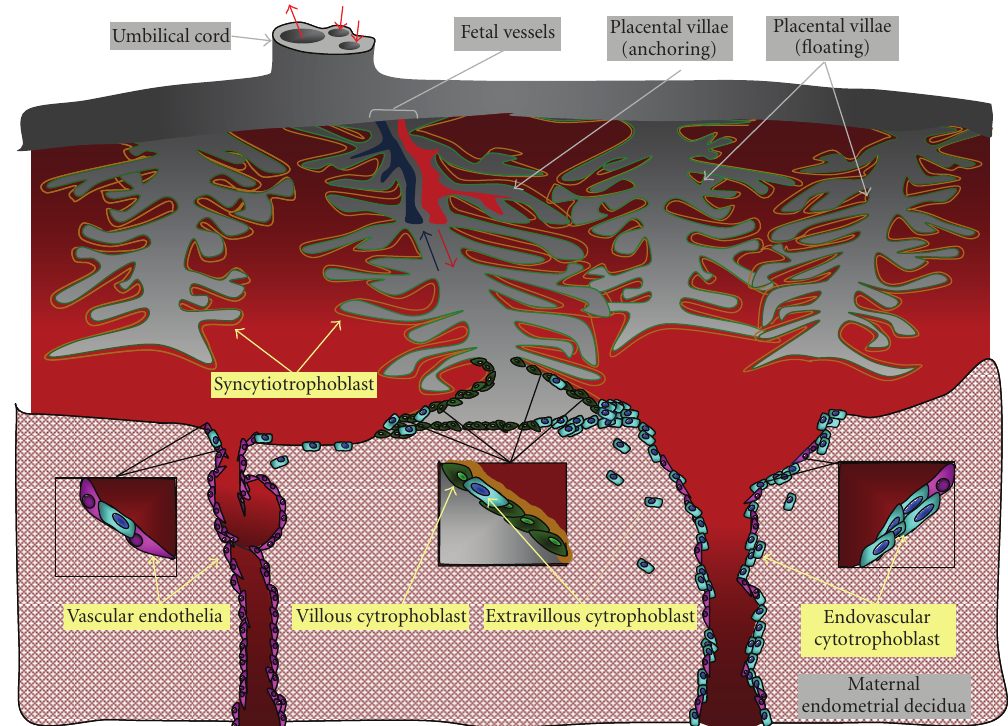
Figure 3: The human maternal-fetal interface. Fetal blood enters and exits the placenta via the umbilical cord. Fetal vessels lie at the core of each placental villae and all villae are lined externally by trophoblast cells. The cells of the inner layer (green) are called villous cytotrophoblast cells. Those of the outer layer develop from the villous cytotrophoblast through syncytialization and are called syncytiotrophoblast (orange). Floating villae are completely bathed in maternal blood; anchoring villae traverse the intervening blood-filled space to attach to the maternal decidua. At the tips of the anchoring villae, a subpopulation of cytotrophoblast cells leaves the villae to invade the maternal endometrial decidua. Here, these extravillous cytotrophoblast (blue) cells encounter populating maternal immune cells. Some extravillous cytotrophoblast cells will invade the maternal uterine arteries and become endovascular trophoblast cells (blue). Appropriate vascular invasion by endovascular trophoblast cells results in remodeling of the uterine vasculature (inset, right) and adequate placental perfusion. Poor vascular invasion by endovascular trophoblast cells results in limited remodeling of the uterine vasculature (inset, left), a condition associated with adverse pregnancy